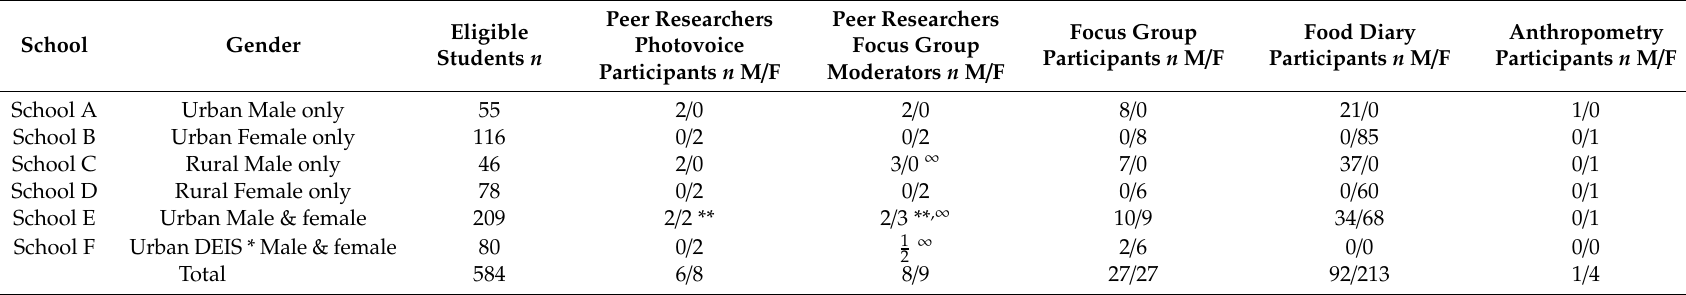
* Delivering Equality of Opportunity in Schools (DEIS)—Disadvantaged Status; ** Two focus and photovoice groups were conducted owing to larger student body in school; ∞ Three peer focus group moderators were preferred by three groups—two shared the moderator role, while one assisted with note taking. All participants were between 15.2 and 17.3 years at the time of data